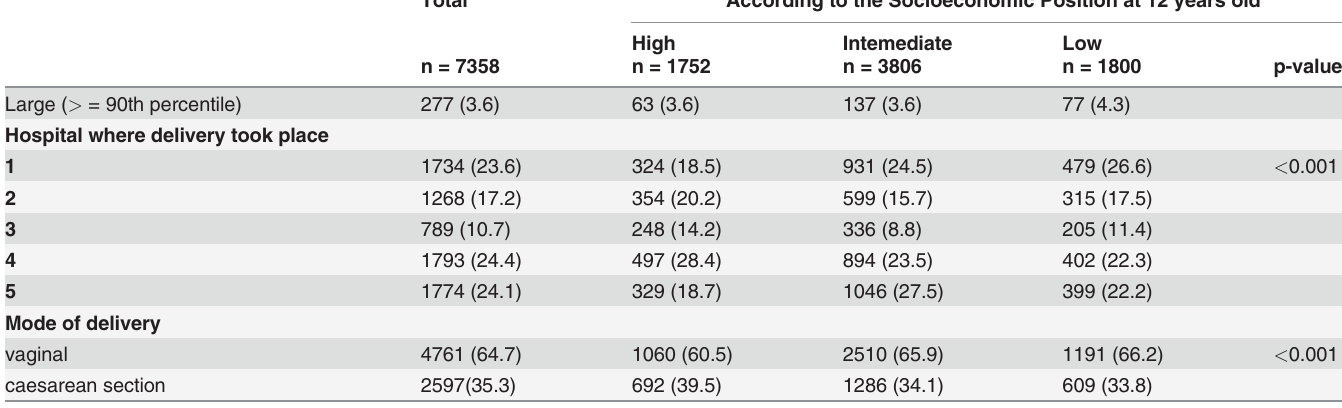
models and respective RR estimates for cesarean section by SEP-12 are also presented in Table 4. Analyses restrict to women aged between 25 and 34 years old (Table 5) and restricted to multiparous women with only a previous delivery (Table 6) revealed similar results to those ob- tained from analyses applied to the whole